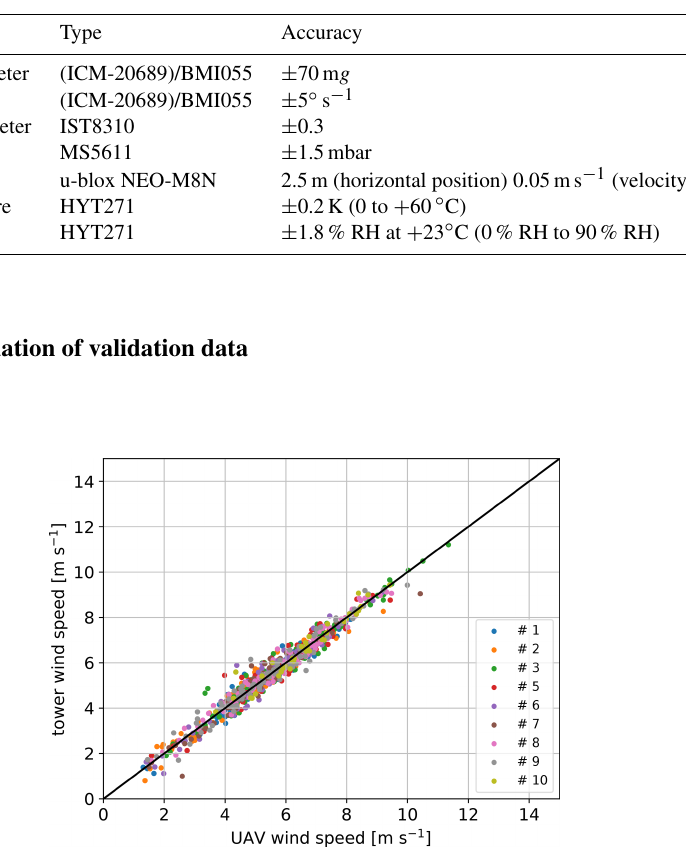
Figure C1. Two-minute averaged wind speed for n = 34 flights drone vs. tower using the individual parameter calibration from the same 34 flights.